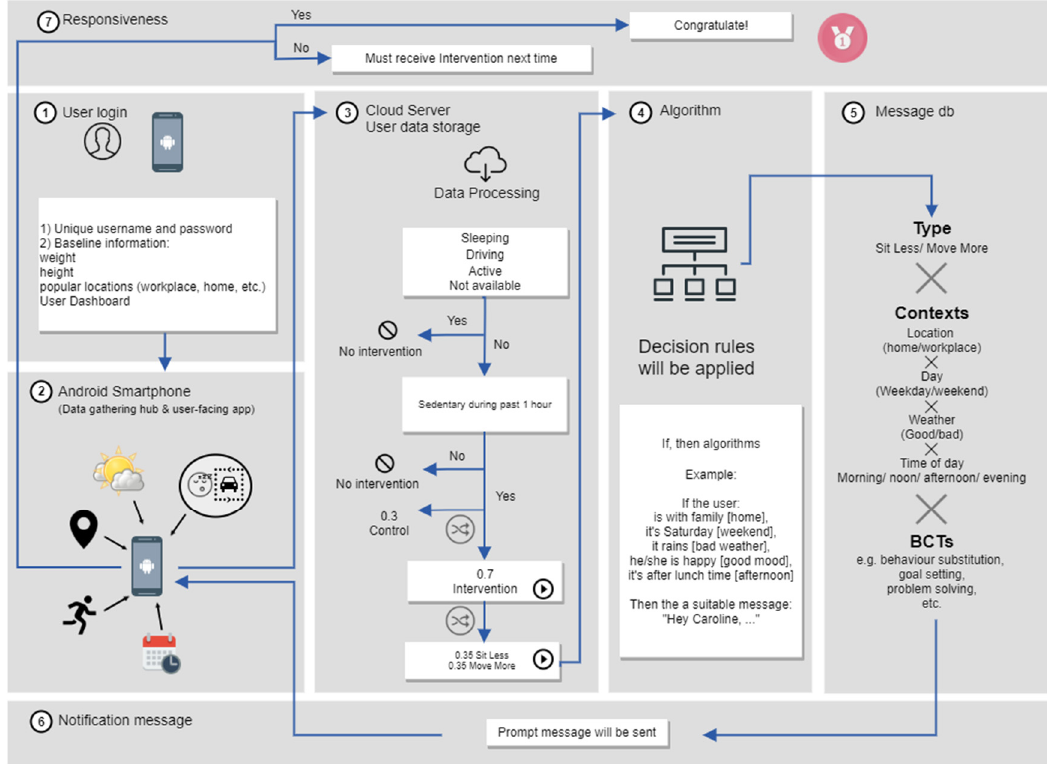
Figure 1. Workflow of the iMOVE app. db, database; BCTs, behaviour-change techniques.